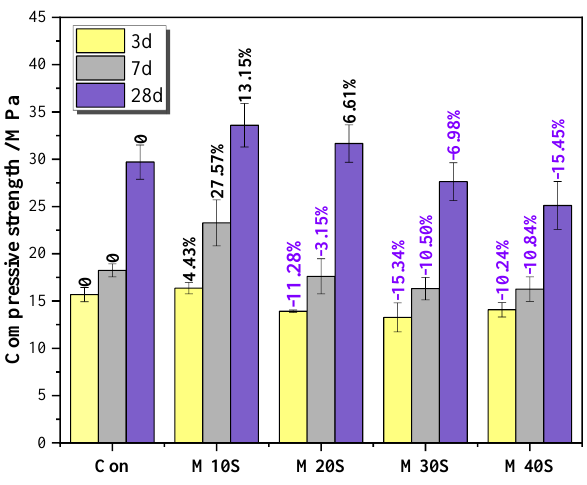
Figure 5. Compressive strength of mortars at 3, 7, and 28 days.